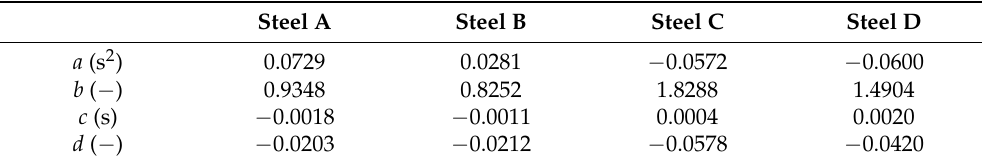
Figure 7. Determination of constants C 1 and C 2 for steel B: ( a ) determination of parameters C 1 and C 2 according to the Equation (19); ( b ) dependence of parameters C 1 and C 2 on strain rate. The values of material constants a (s 2 ), b ( − ), c (s) and d ( − ) intended for the prediction of the strain hardening exponent C of all investigated steels (according to relation (20)) are given in Table 6. Table 6. The material constants intended for prediction of strain hardening exponent C of investigated steels according to Equation